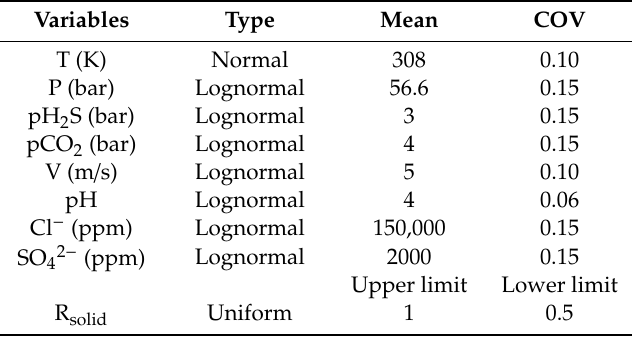
Table 1. Operating parameters of the gas pipeline system.